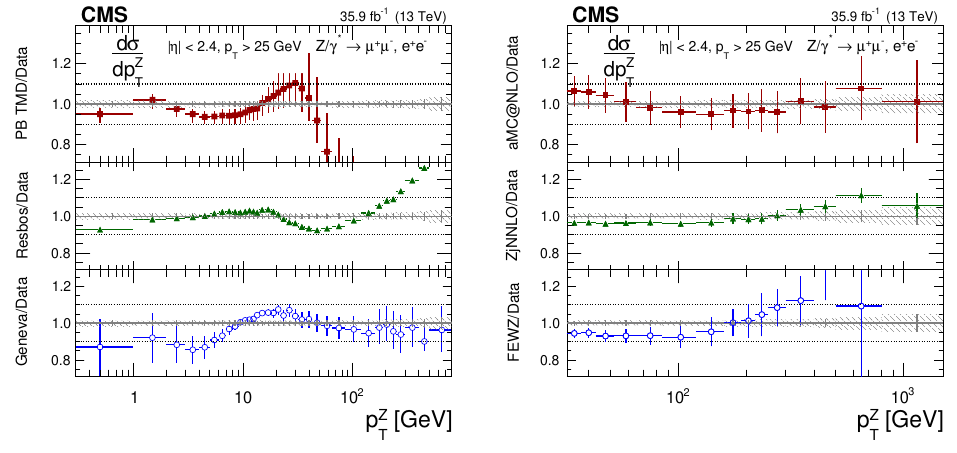
Figure 7 . The ratios of the predictions to the data in bins of p Z for the combination of the dimuon T and dielectron (cid:12)nal states. The shaded bands around the data points (black) correspond to the total experimental uncertainty. The left plot shows comparisons to the predictions with PB TMD (square red markers), RESBOS (green triangles), and GENEVA (blue circles). The right plot shows the p Z distribution for p > 32 GeV compared to the predictions with MadGraph 5 a mc@nlo (square T T red markers), Z + 1 jet at NNLO (green triangles), and FEWZ (blue circles). The error bars around the predictions correspond to the combined statistical, PDF, and scale uncertainties. Only the statistical uncertainties are shown for the predictions with RESBOS